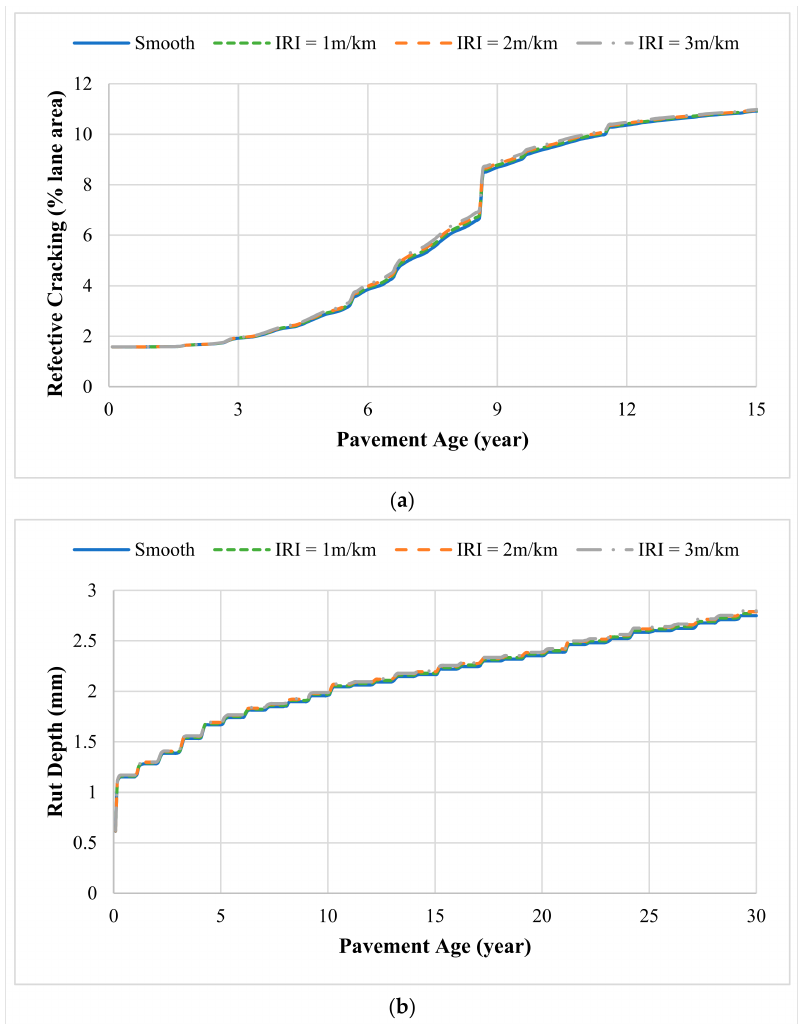
Figure 7. ( a ) Fatigue cracking (reflective); and ( b ) rut depth under the static and dynamic loads on pavement structure on minor highway (10% existing